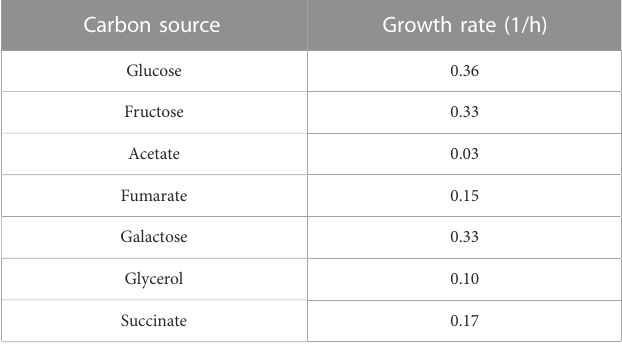
TABLE 1 Biomass production on the carbon source.